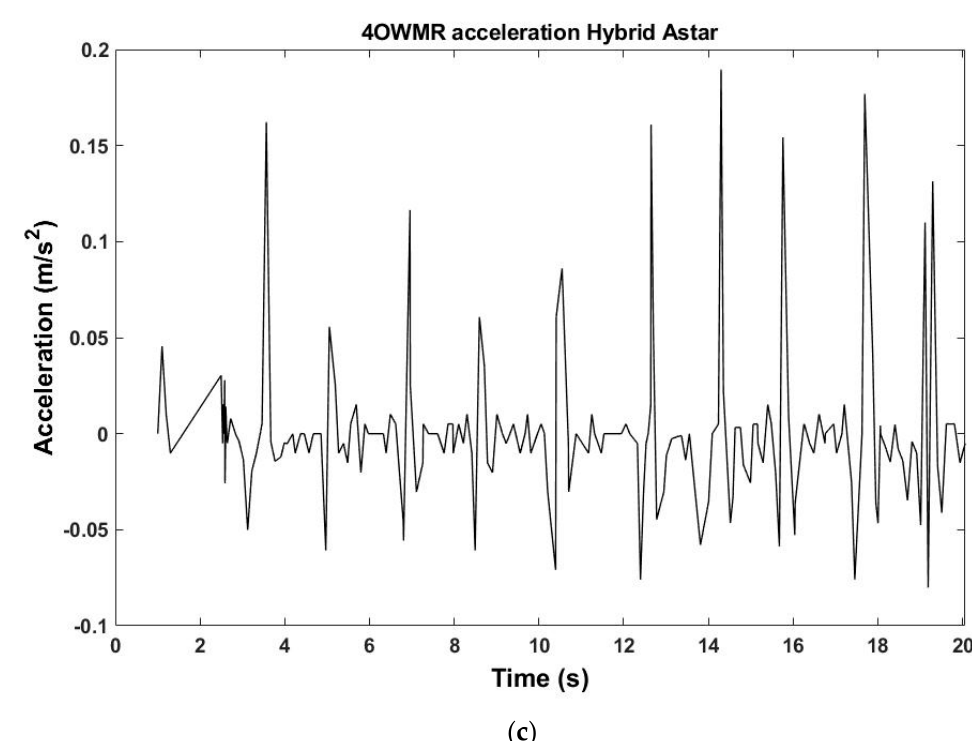
Figure 11. ( a ) The velocity reading of each wheel of the 4OWMR during Hybrid A* implementation for Map2. ( b ) The velocity of the 4OWMR during Hybrid A* implementation for Map2. ( c ) The acceleration of the 4OWMR during Hybrid A* implementation for Map2.